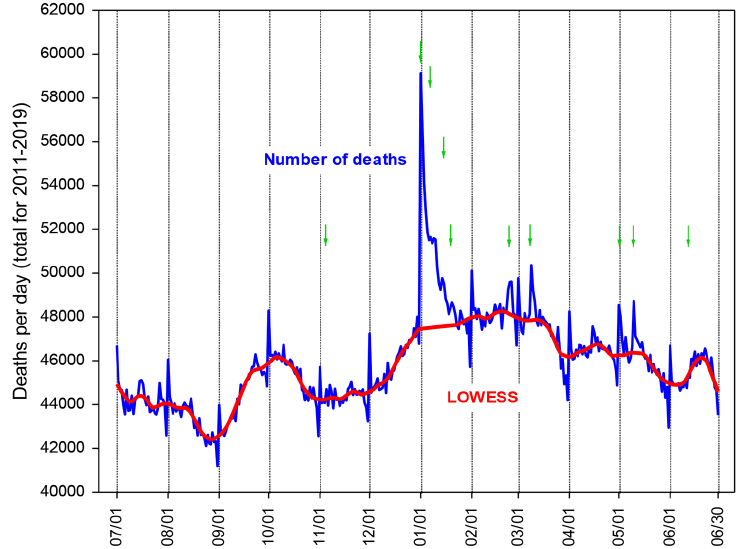
Fig. 1. The daily number of deaths in Russia, the sum of the indicators for 2011–2019 (blue line) and the moving average LOWESS for non-holidays, extrapolated to holidays (red line). Note: The vertical dashed lines indicate the first days of the months, green arrows indicate the main holidays, sequential- ly: November 4; January 1, 7, 14 and 19; February 23; March 8; May 1 and 9; June 12. Source: authors’ calculations based on modelling and Rosstat